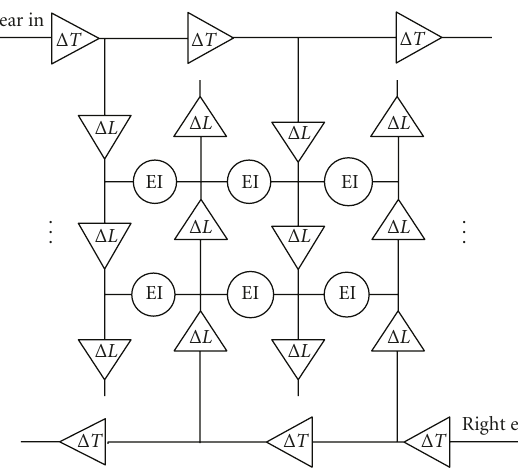
Figure 6: Breebaart model: delay-attenuation